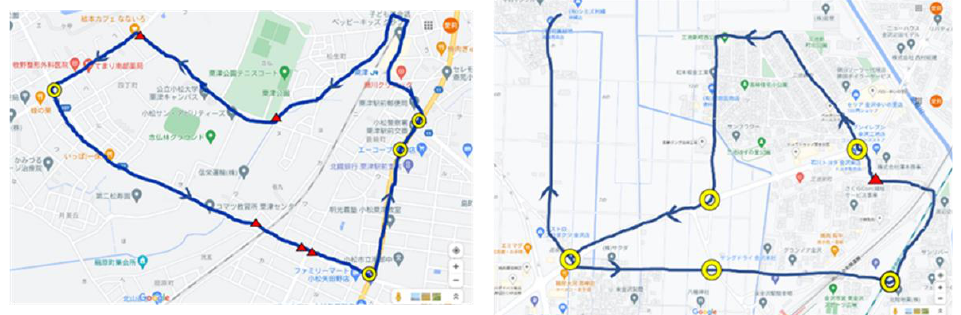
Figure 9. The subject drove route A ( left ) and route B ( right ). The yellow circle on the map means an intersection.